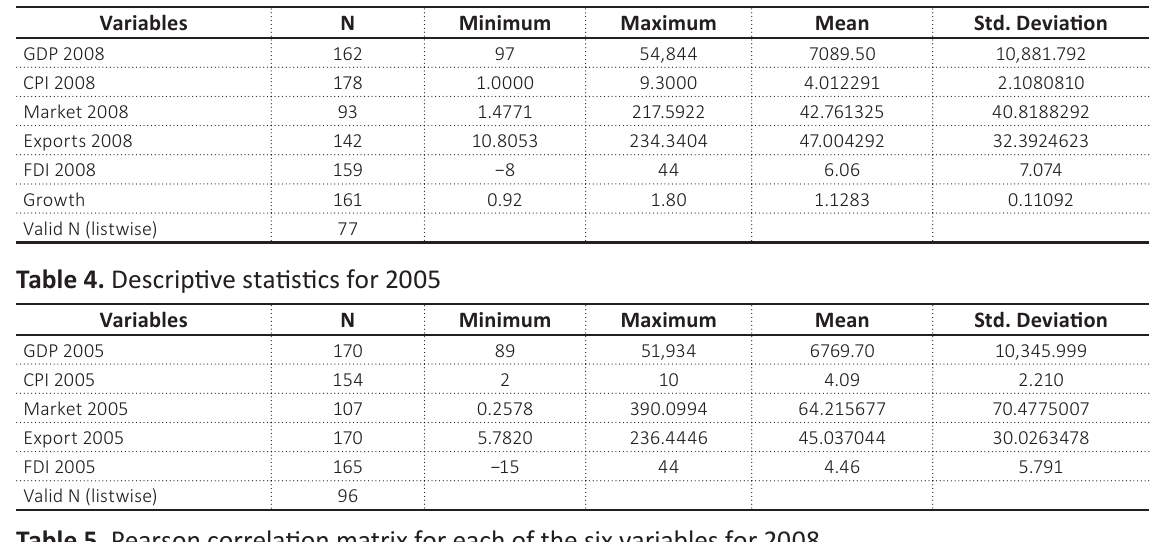
Table 3. Descriptive statistics for 2008